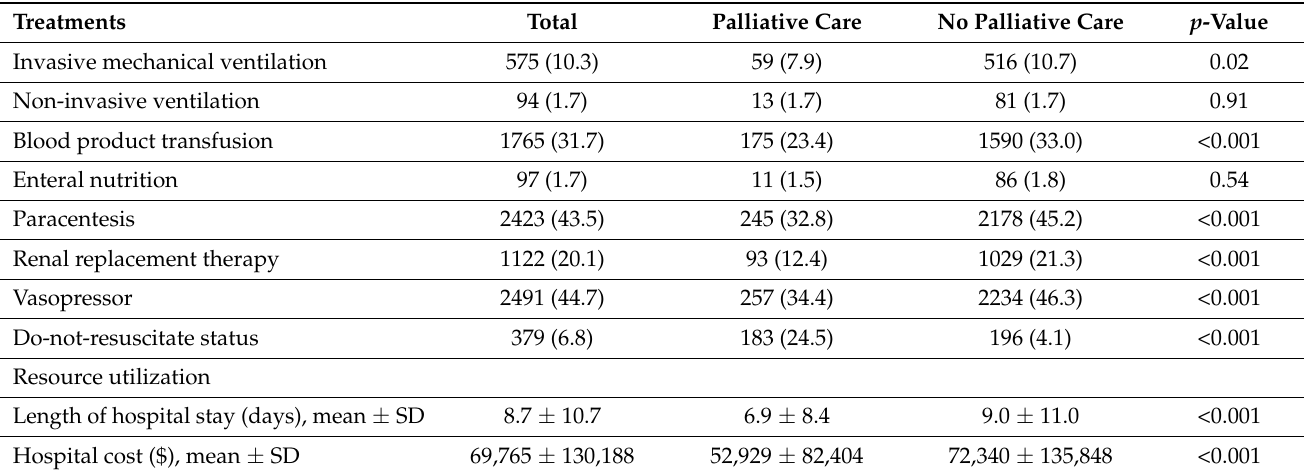
Table 3. In-hospital treatments and resource use between hospital admissions for hepatorenal syndrome with and without palliative care service